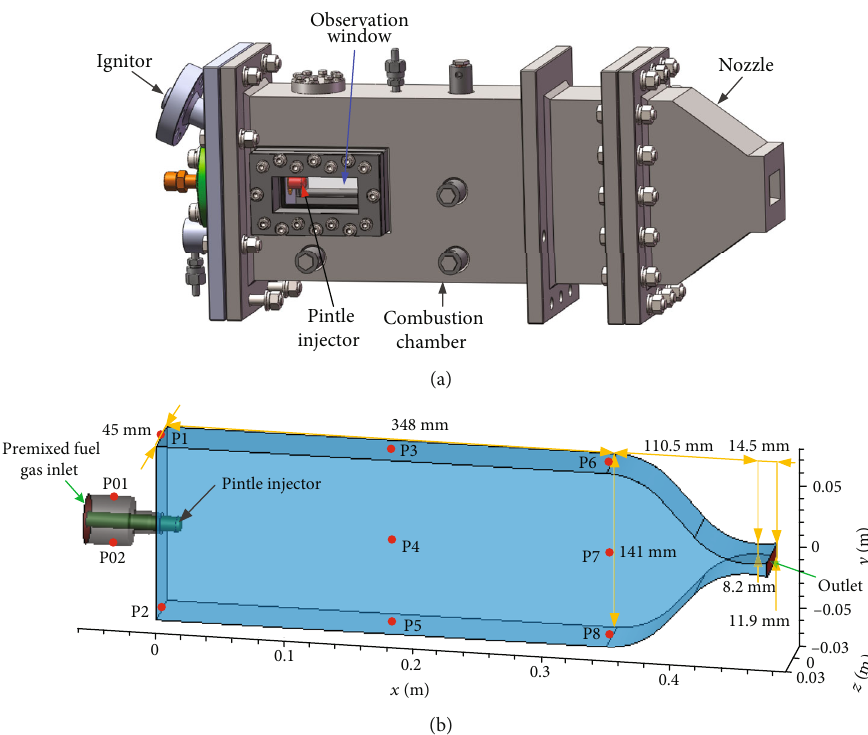
Figure 1: LOX/GCH pintle rocket engine prototype: (a) three-dimensional structure; (b) computational domain 4